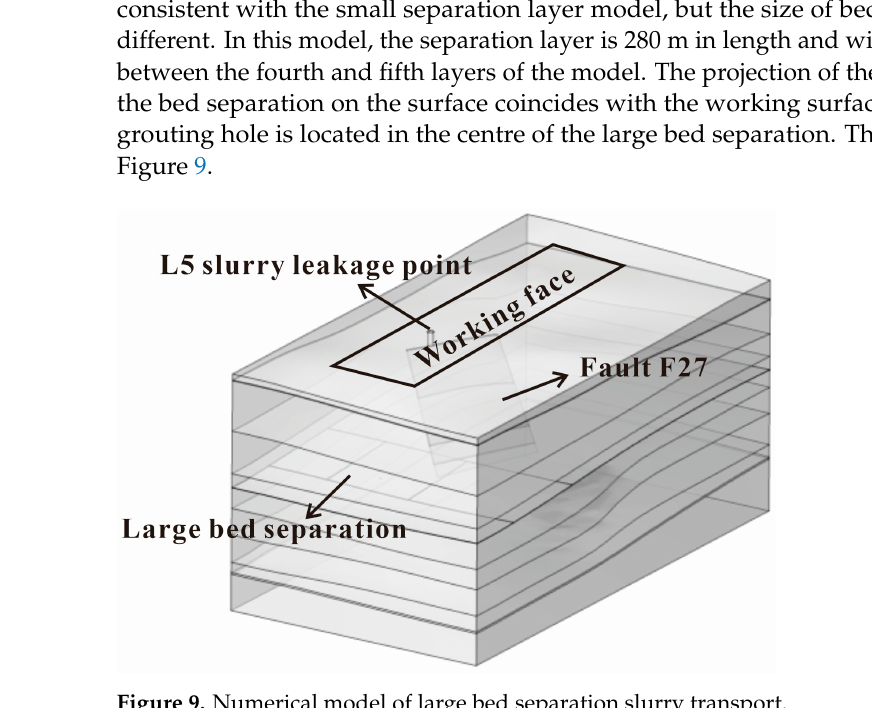
Figure 9. Numerical model of large bed separation slurry transport.